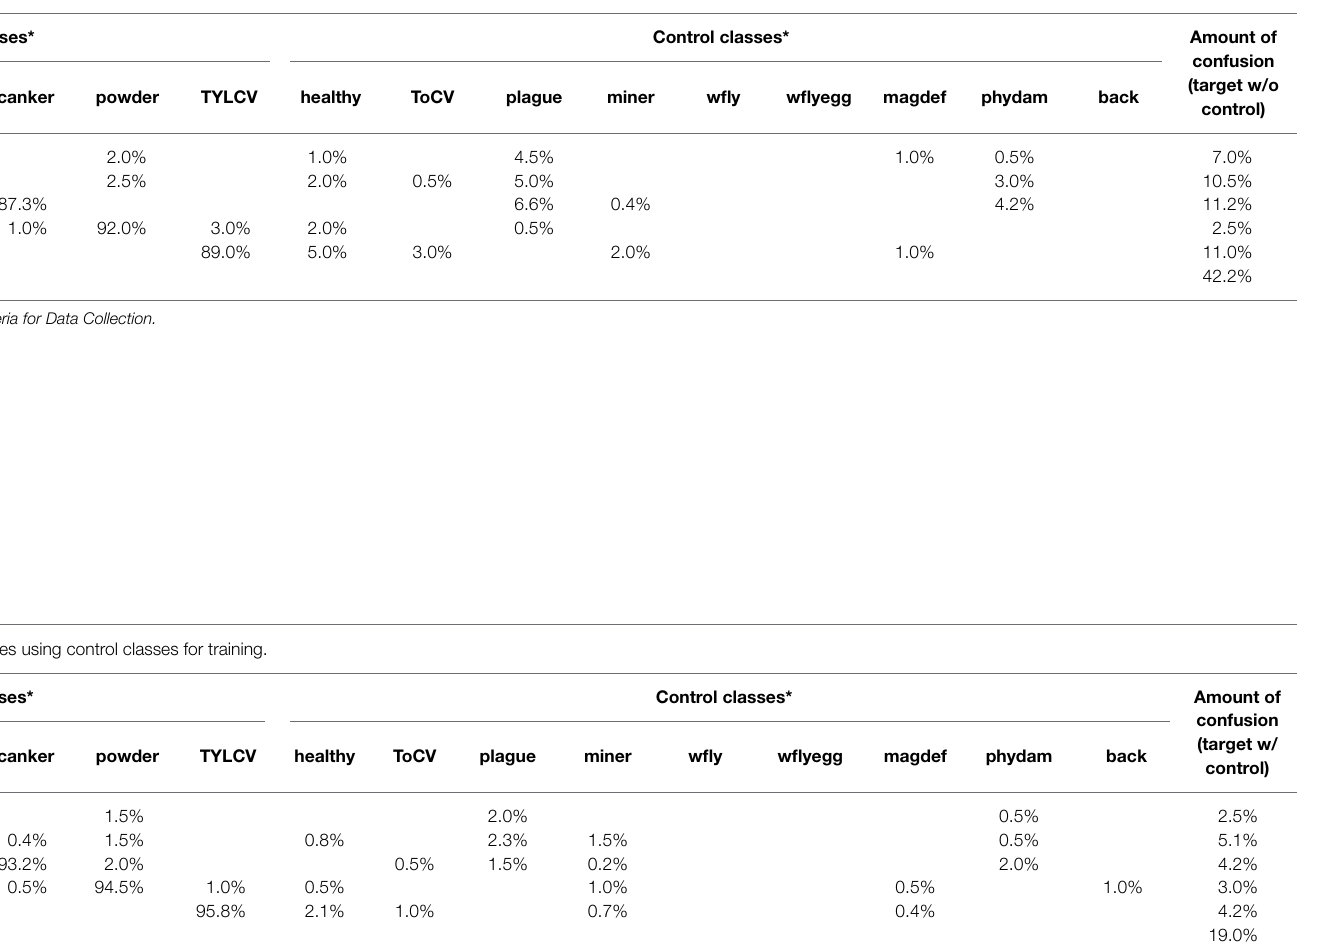
TABLE 5 | Confusion matrix of target classes without using control classes for training.